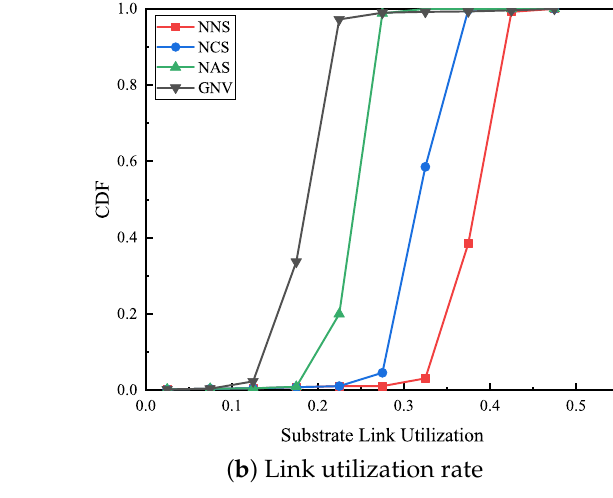
Figure 5. Resource